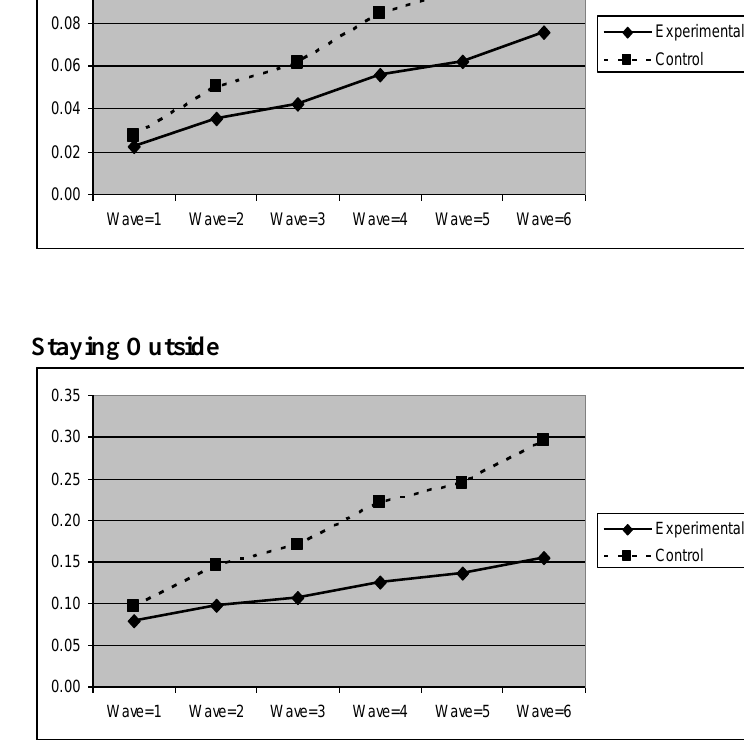
FIGURE 7 . Growth trajectories of the experimental group (participants who joined the Tier 1 Program only) and control group using the item score of having sexual intercourse as the outcome indicator.